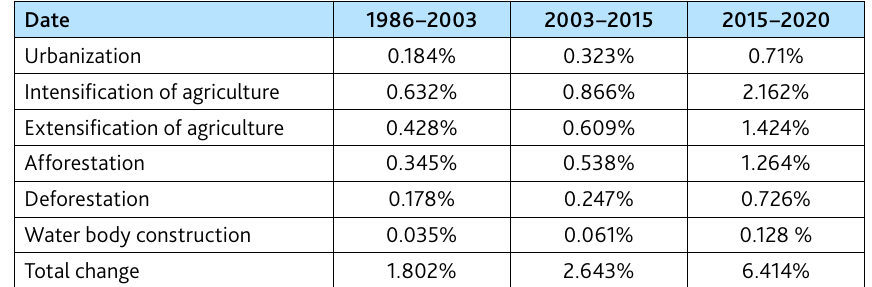
Table 2. Mean yearly categorized land use changes, based on the predicted change